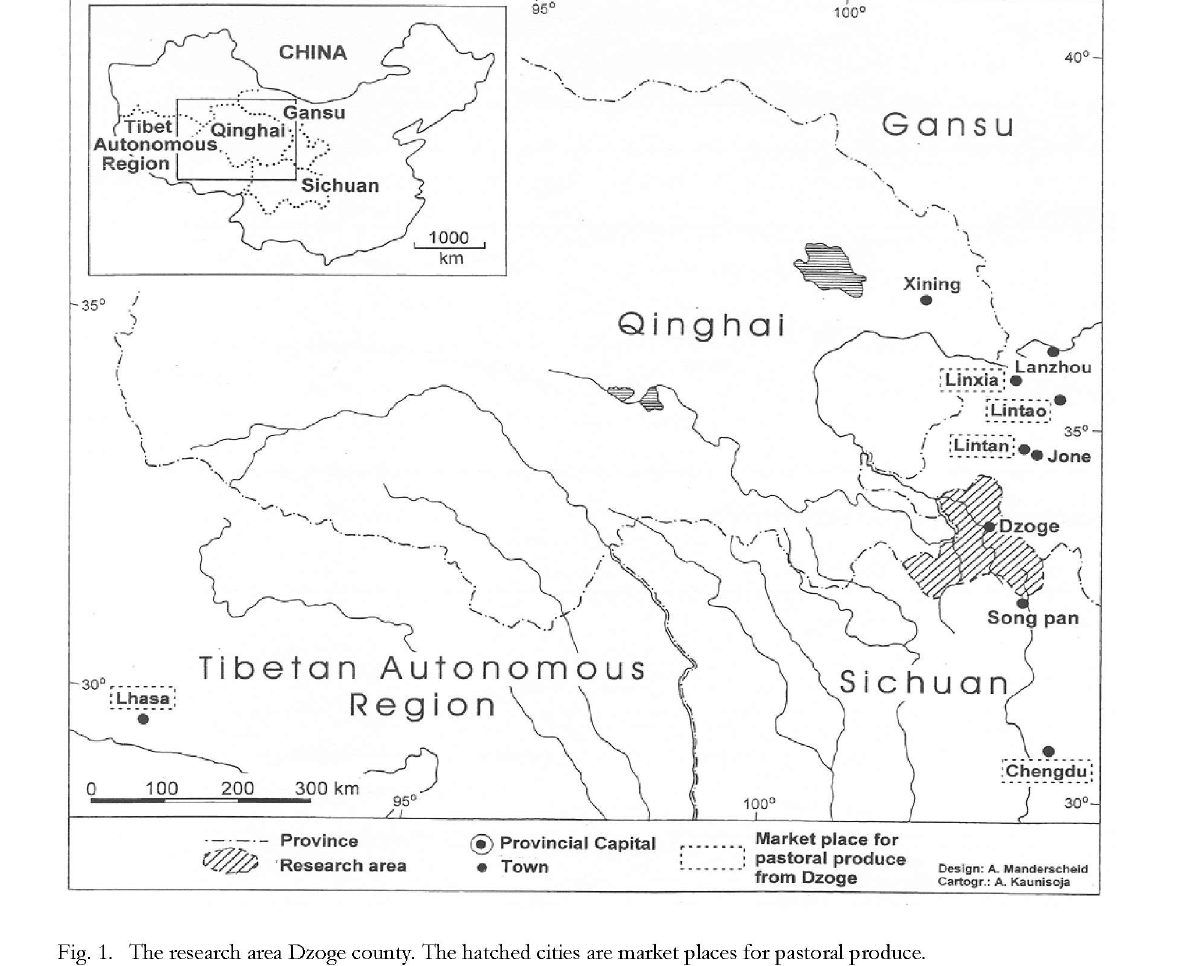
Fig. 1. The research area Dzoge county. The hatched cities are market places for pastoral